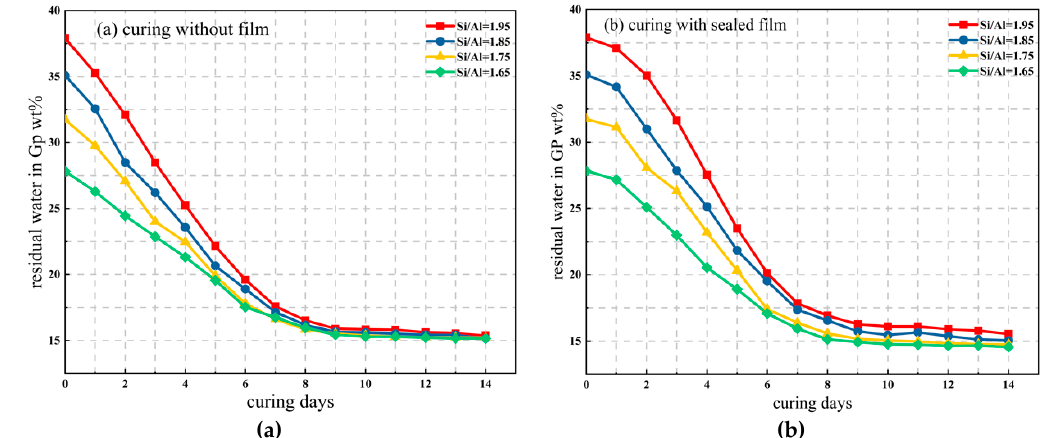
Figure 13. Water remaining in samples with various Si/Al ratios during curing in sealed and unsealed molds for 6 h and aging for 14 days in ambient environment, ( a ) curing without film, ( b ) curing with sealed film.